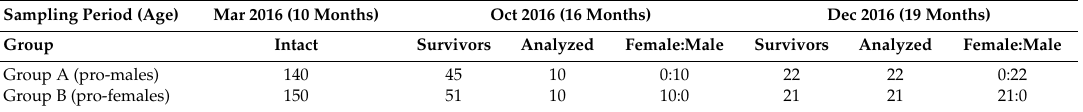
Table 1. Changes of sex ratio from one to two years of age in the Yesso